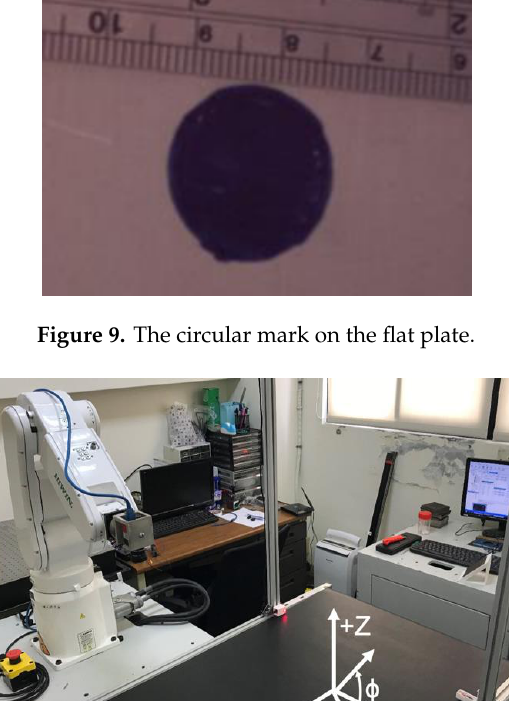
Figure 10. The directional angle